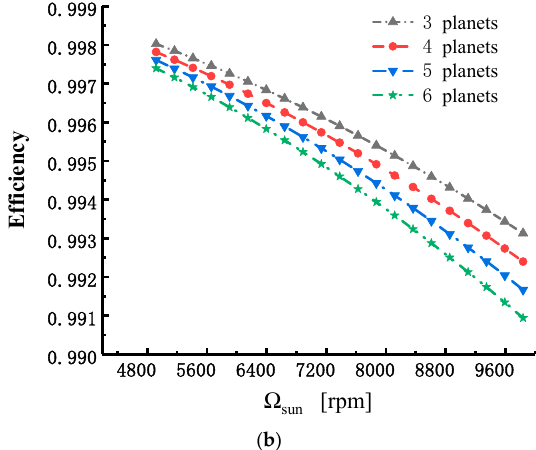
Figure 17. Variation of efficiency loss with input speed. ( a ) Gear meshing efficiency loss; ( b ) windage efficiency loss.